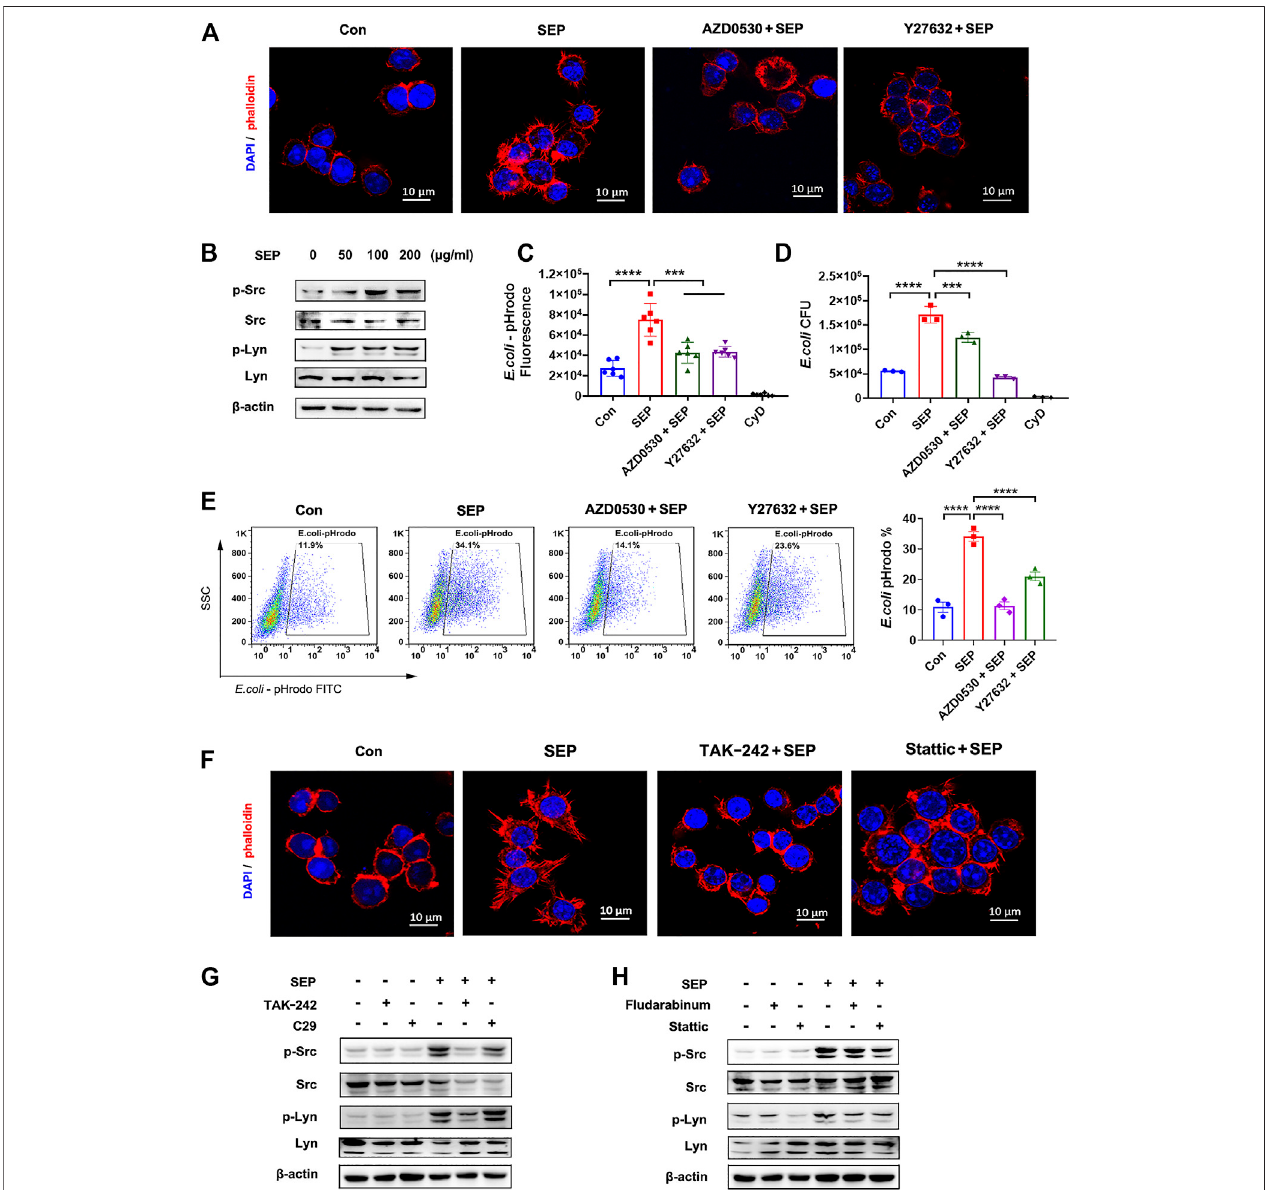
FIGURE 5 | SEP promotes fi lopodia formation via TLR4/STAT3 axis. (A) The effects of SEP on the fi lopodia formation of macrophages. RAW264.7 cells were administrated with Src family inhibitor AZD0530 (10 μ M) or ROCK1 inhibitor Y-27632 (20 μ M) for 2 h prior to E. coli infection. The cellular fi lamentous actin were stained withrhodaminephalloidinandthecellularDNAwithDAPI. (B) TheeffectsofSEPonproteinlevelsofp-Srcandp-Lynweredetermined bywesternblot. (C) Theeffectsof AZD0530 or Y-27632 on SEP induced phagocytosis of pHrodo- E. coli were measured by fl uorescence intensity, (D) or phagocytosis of live E. coli by gentamicin protection assay,or (E) phagocytosis ofpHrodo- E. coli by fl ow cytometry. (F) The effects ofTAK-242or Stattic on SEP induced fi lopodia formation. (G,H) The effects of TAK-242, or C29, or Stattic, or Fludarabine on SEP induced protein levels of p-Src and p-Lyn were determined by western blot. *** p < 0.001, **** p < 0.0001.